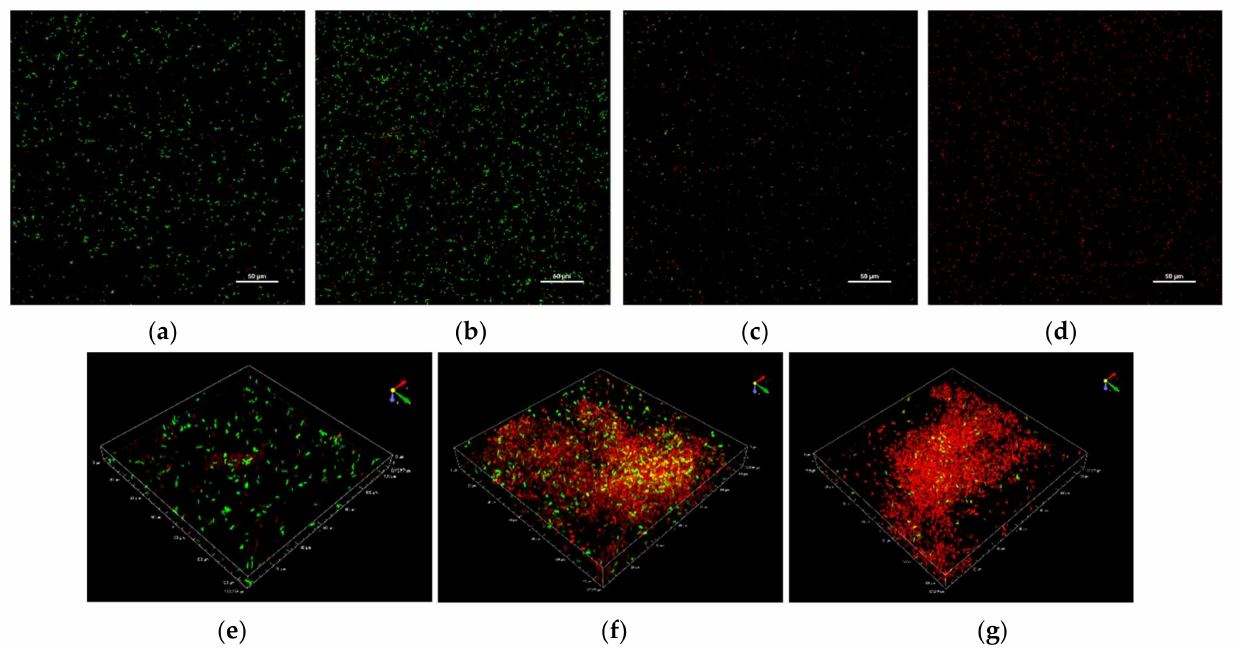
Figure 2. Representative CLSM images of L. monocytogenes ATCC 7644 cells exposed to CHY con- centrations for 1 h at 37 ◦ C. Control sample ( a ), 250 µ L mL − 1 ( b ), 350 µ L mL − 1 ( c ), and 500 µ L ml − 1